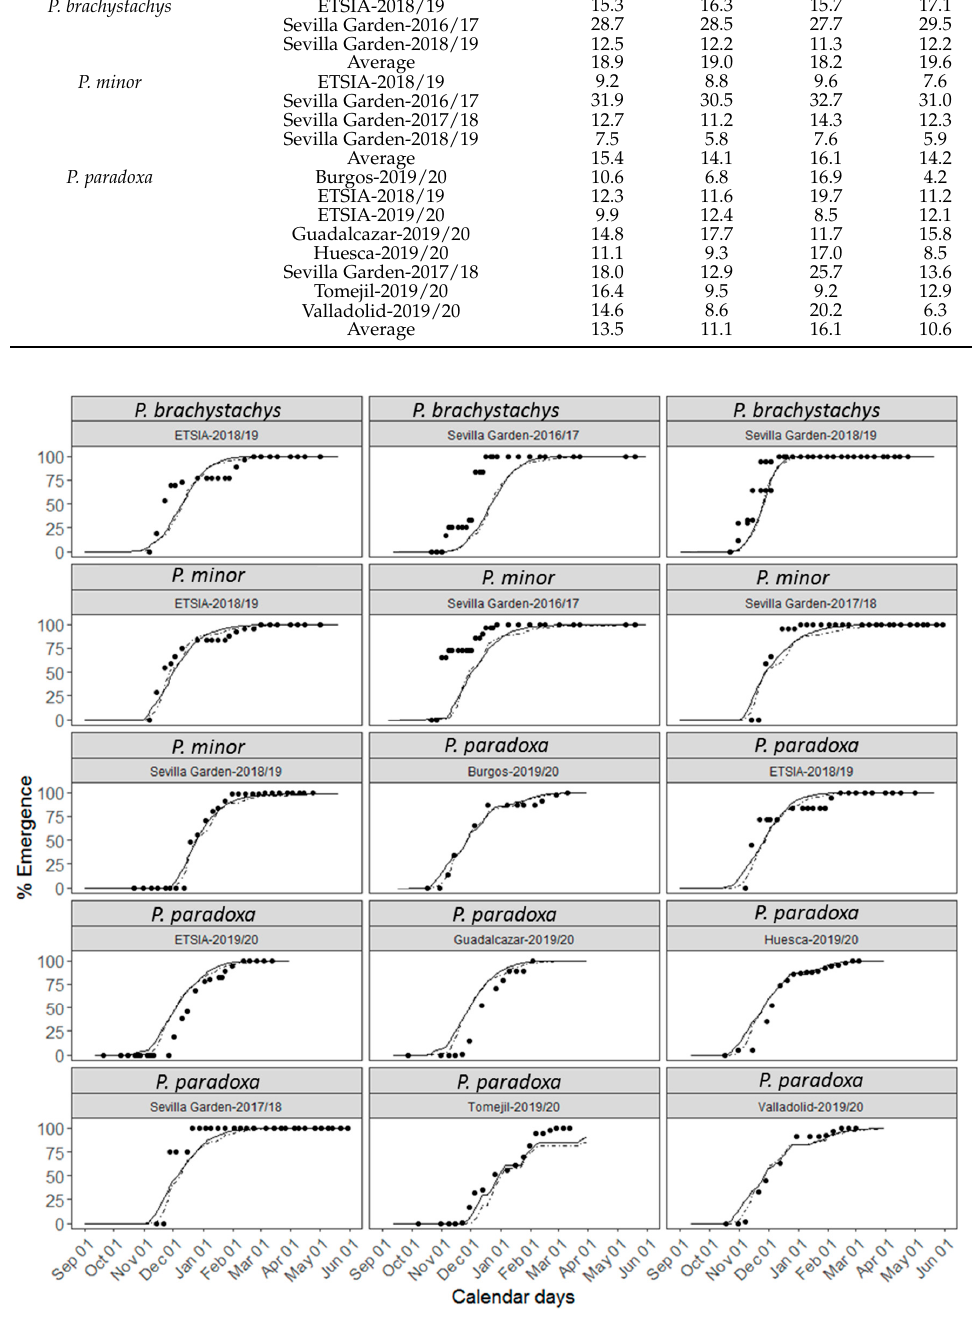
Figure 6. Predicted emergence of the three Phalaris species using parametric (black line) and non ‐ parametric (dotted line) hydrothermal model at each validation location. The black dots show observed seedling emergence.